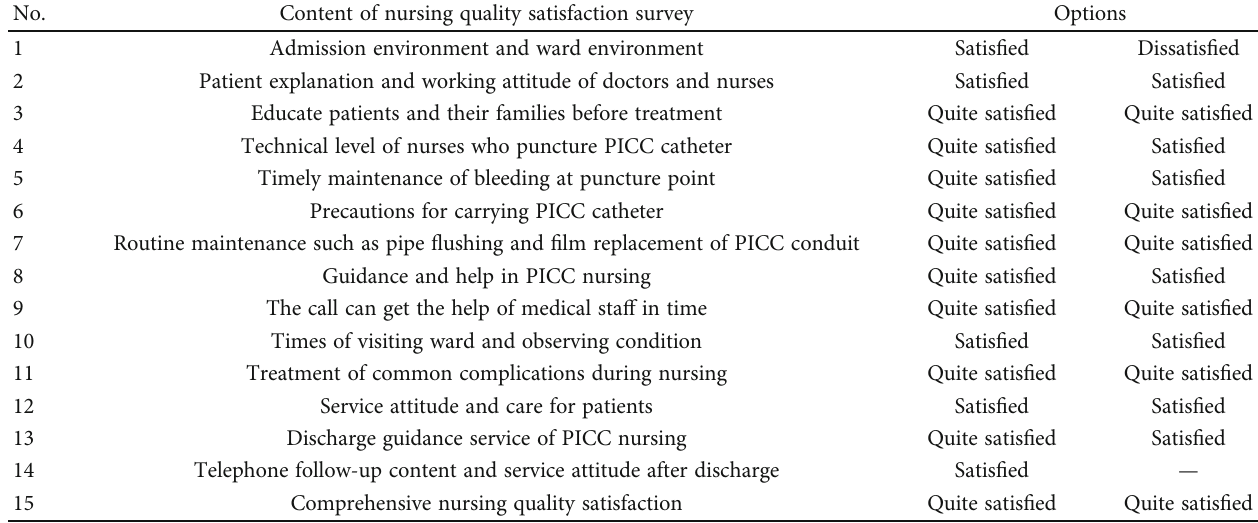
Table 3: Satisfaction questionnaire of patients ’ family members (data source: self-statistics of the study).